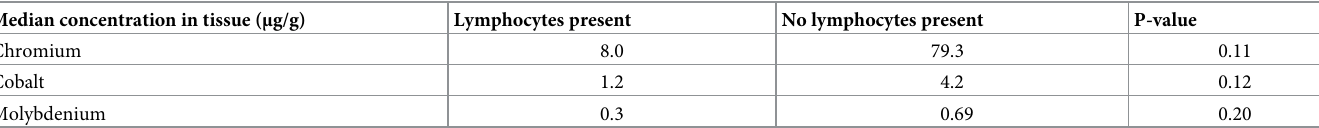
Table 7. Median metal concentration in tissues with lymphocytes present and tissues with no lymphocytes present in the hip resurfacing group (n = 20). Median concentration in tissue (μg/g)